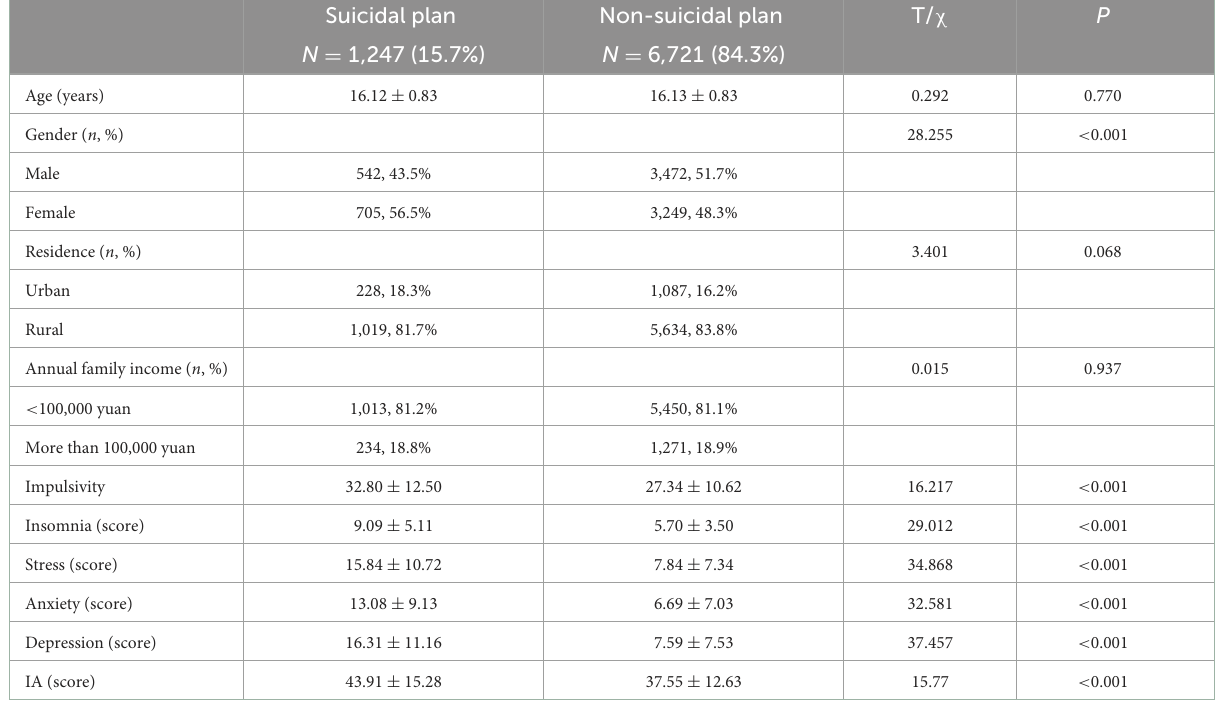
TABLE 2 Demographic data and characteristics of the population with and without a suicidal plan.